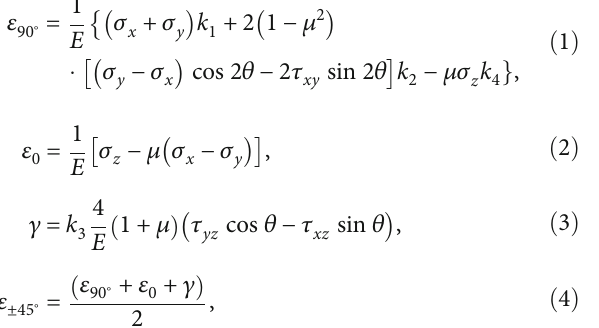
Figure 6: Stress relief curve of no. 2 measuring point.